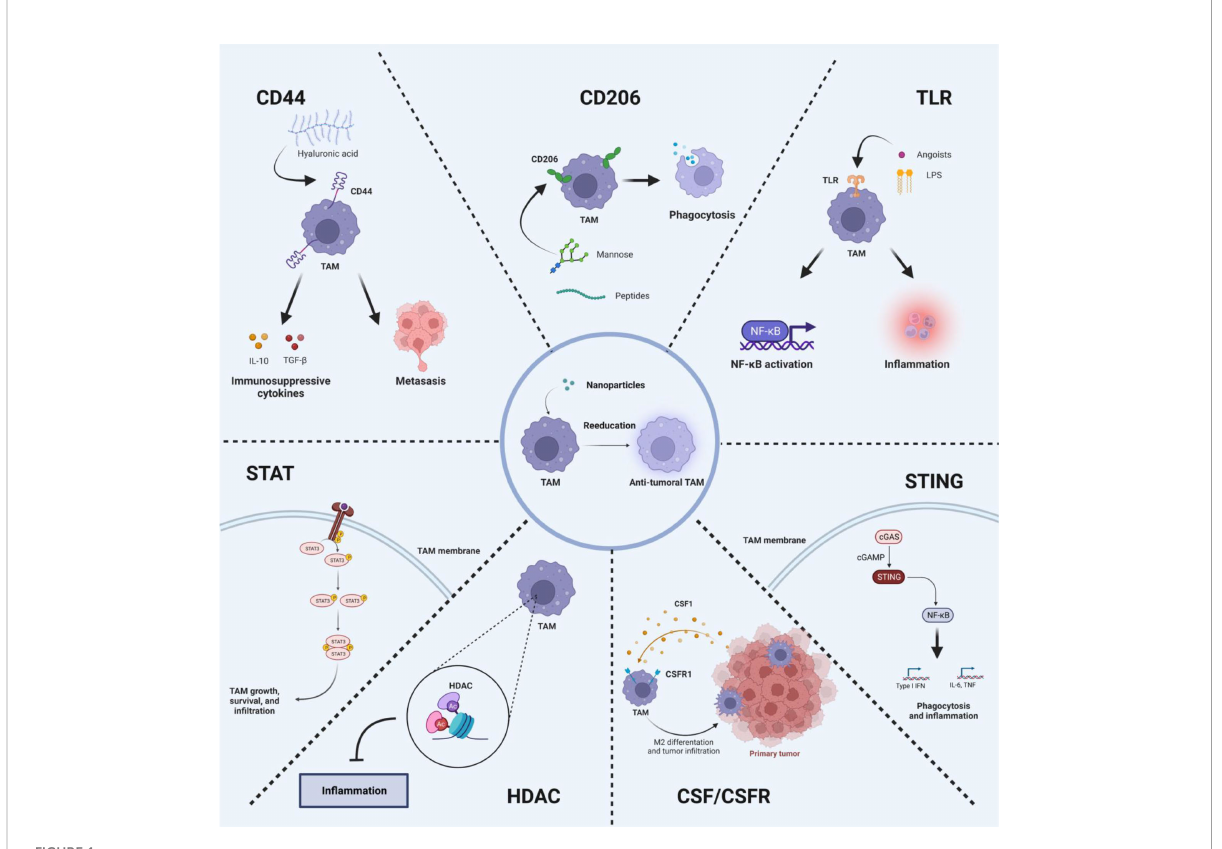
FIGURE 1 Signaling pathways for the precise reeducation of